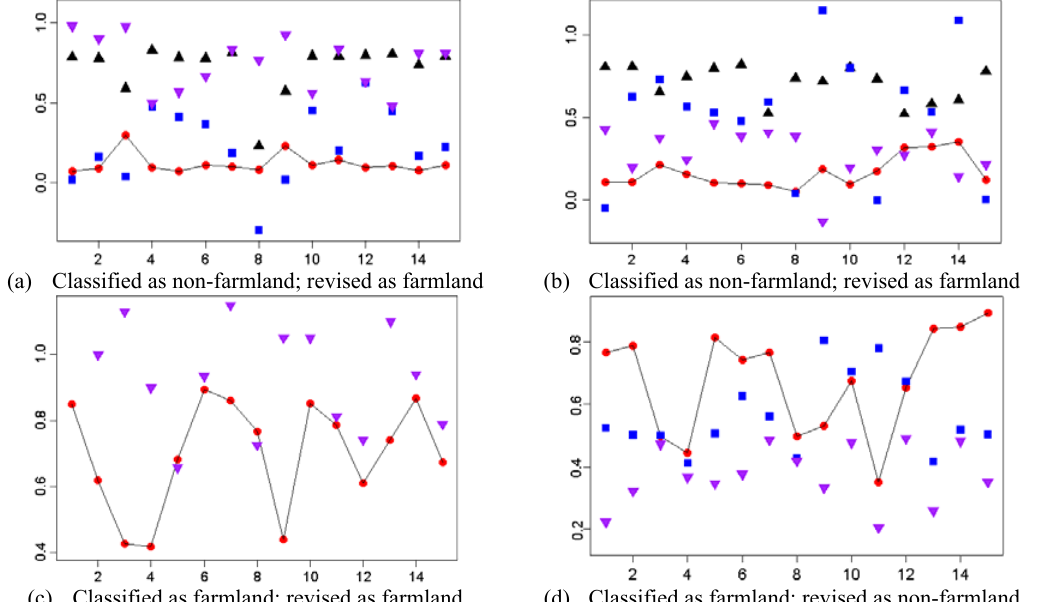
Figure 3. The Probabilities of the SVM Classifier and the SK Method (e.g.,